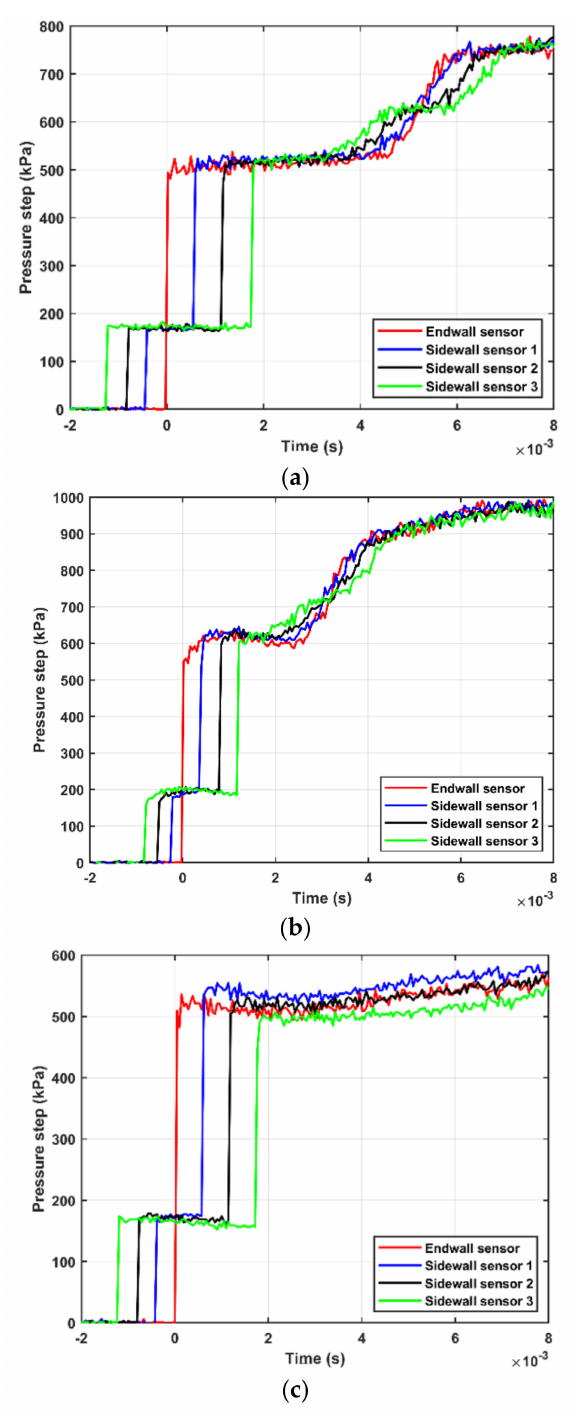
Figure 2. A typical shock wave generated by the shock tube. ( a ) Double diaphragms; ( b , c ) fast- opening valve before and after elongating the shock tube,